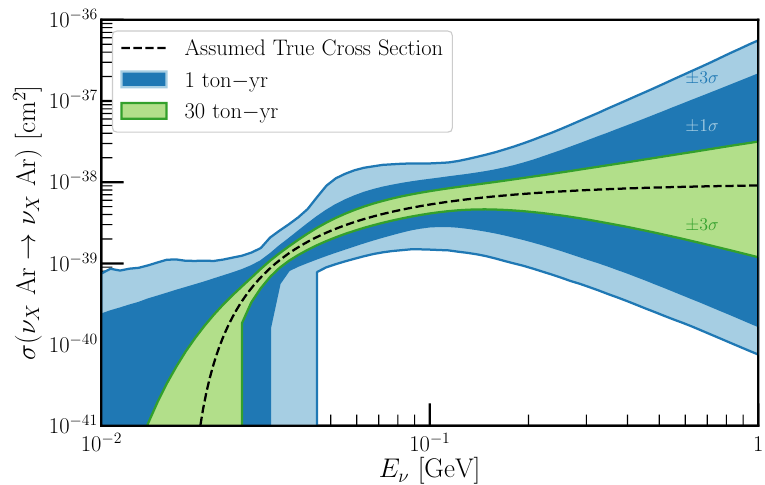
Figure 15. Similar to figure 9, the implied measurement of the coherent cross section as a func- tion of neutrino energy, now with a zero-background assumption. The detector is assumed to be a distance of 18 m from the LHC Beam Dump instead of 15 m, resulting in a smaller signal rate. Systematic uncertainties ( 5% overall flux uncertainty and 10% kaon-to-pion production ratio un- certainty) are still included and marginalized